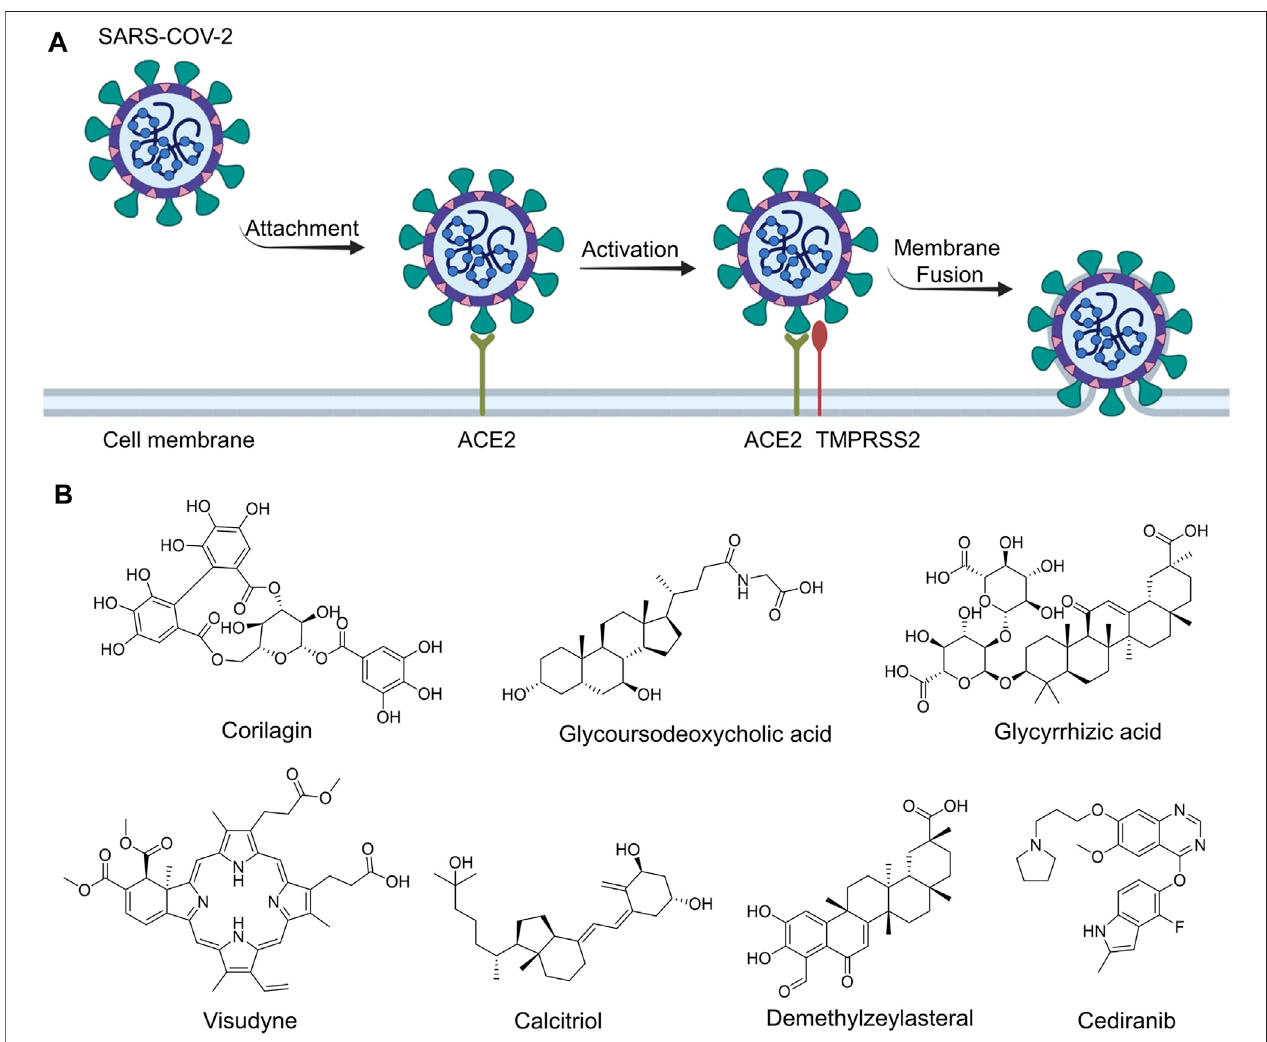
FIGURE 1 | The routes of SARS-CoV-2 invade into host cells (A) and several representative inhibitors against SARS-CoV-2 S-RBD/ACE2 interaction (B) .